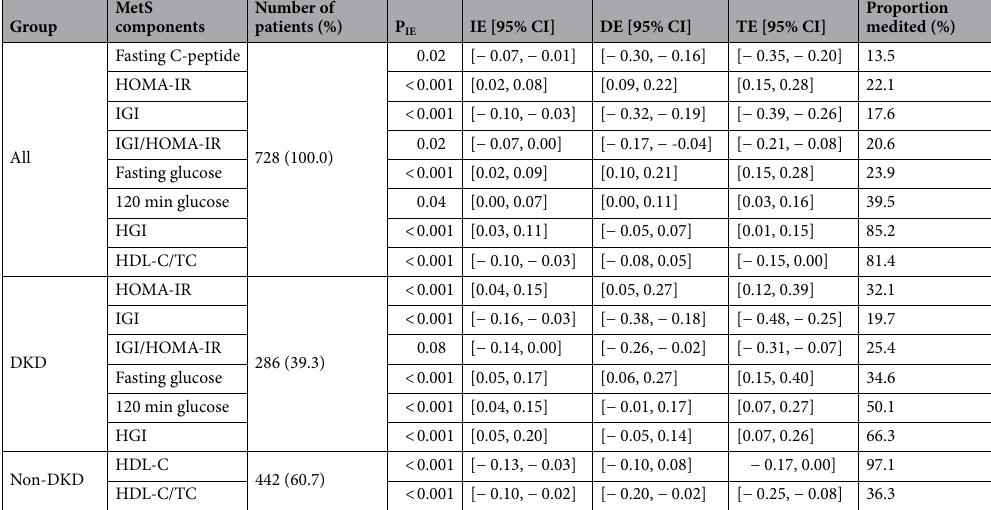
Number of patients